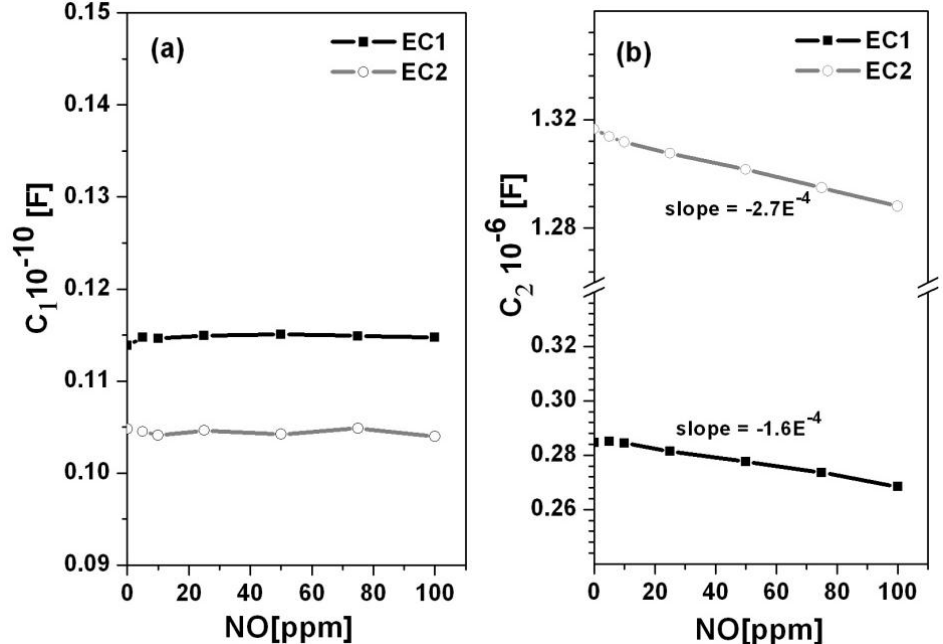
Figure 3. The capacitance versus NO concentration is shown for the ( a ) high and ( b ) low frequency arcs associated with the EC1 and EC2